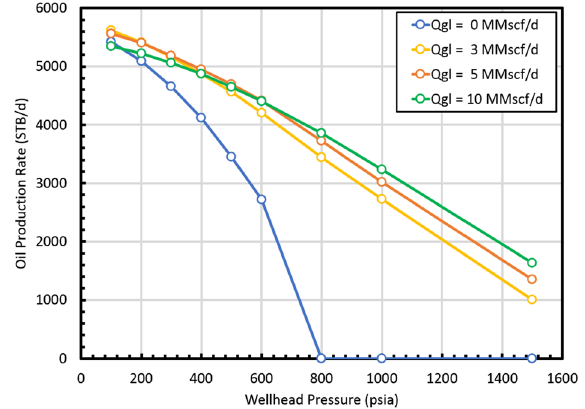
Fig. 5 Influence of the producing GOR on the performance curve of pipeline A. The WC is held constant and equal to 45% and the inlet pressure is equal to 700